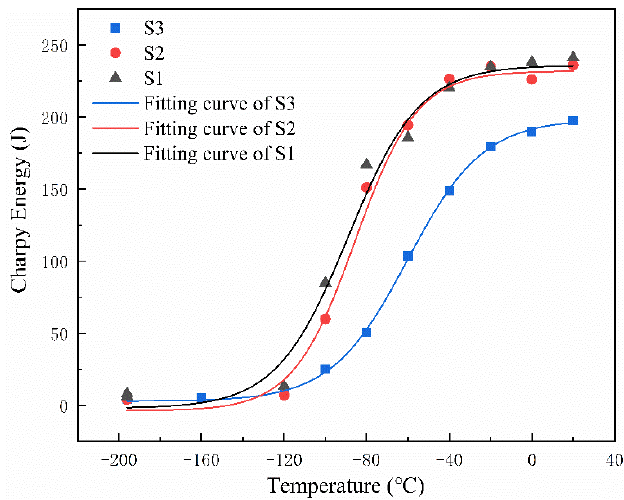
Figure 5. The impact absorption energy–test temperature along with the Boltzmann function fitting based on the experimental data.